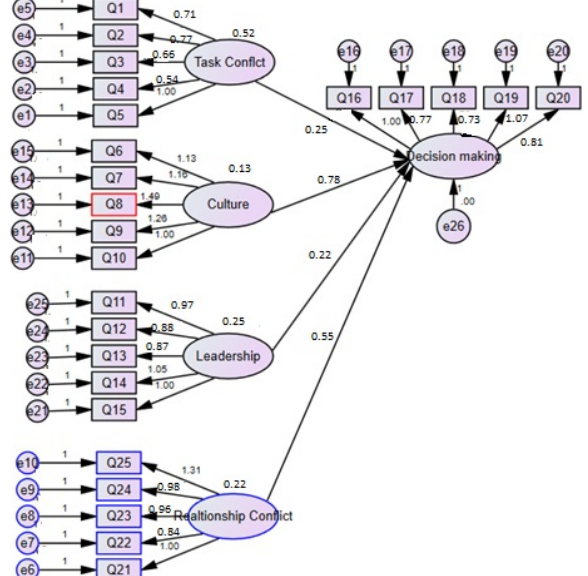
Figure 2. Decision-making module. Table 3. Model Fit.